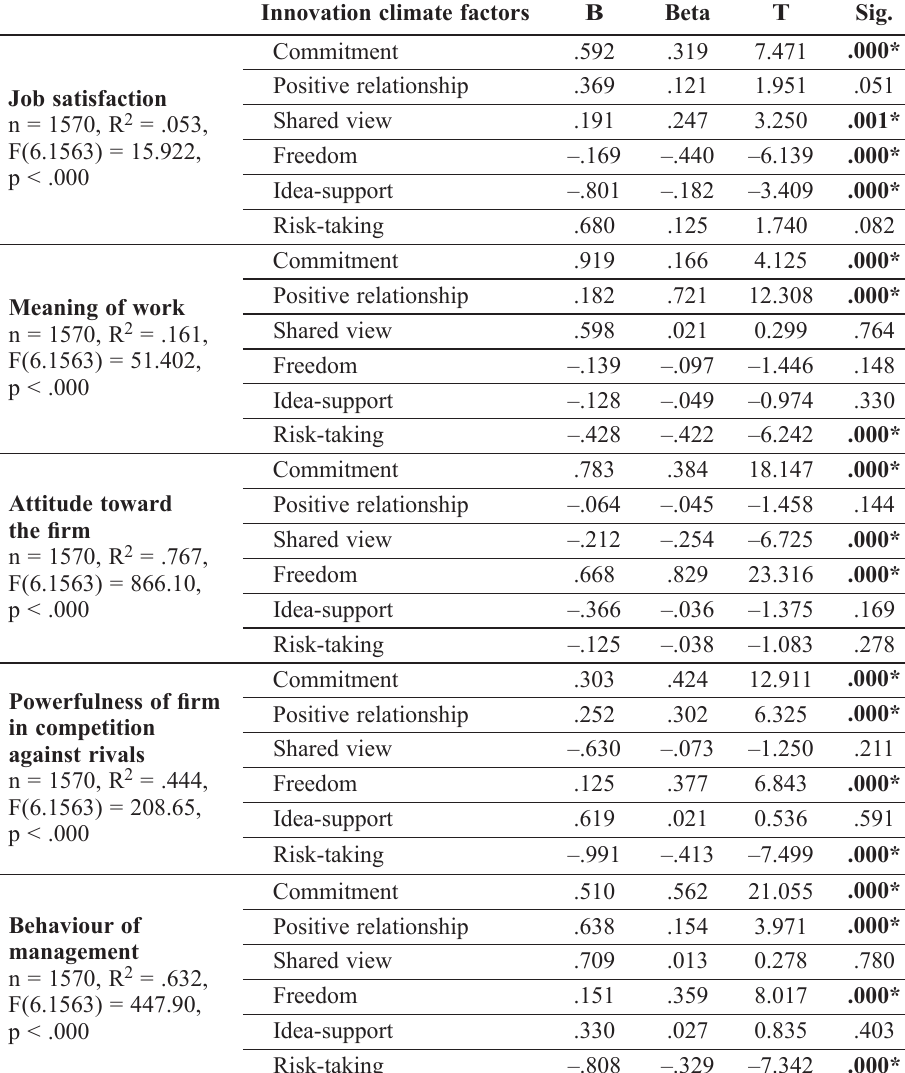
Table 2. Connections between the innovation climate and individual and organisational level factors in Japan (according to standardised regression coefficient Beta) Innovation climate factors B Beta T